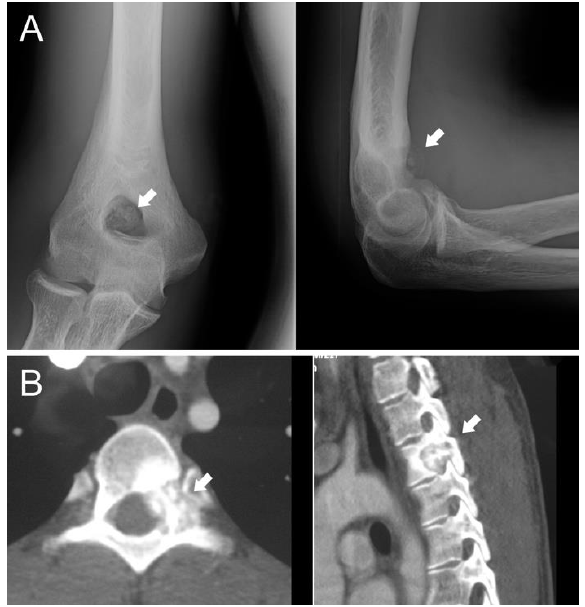
Figure 1. ( A ) Twenty-two-year-old male patient affected by stage 2 distal humerus OBL (white arrows): the lesion was considered suitable for intralesional surgery; ( B ) twenty-one-year-old male patient affected by a D3 left pedicle OBL (white arrows): wide resection was performed to decrease the risk of local recurrence.